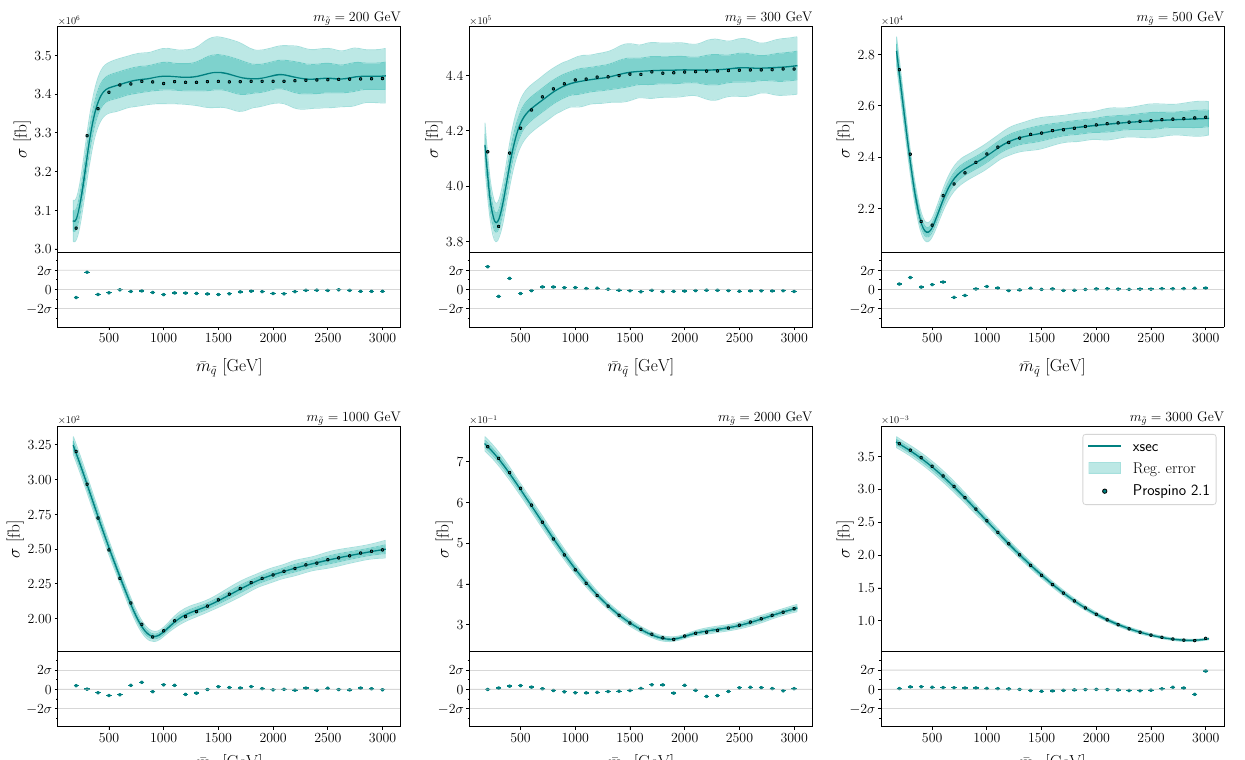
Fig. 4 Gluino pair-production cross-section as a function of average first and second-generation squark mass for a set of different gluino masses. Shown is the central xsec prediction (solid line), the 1 σ and